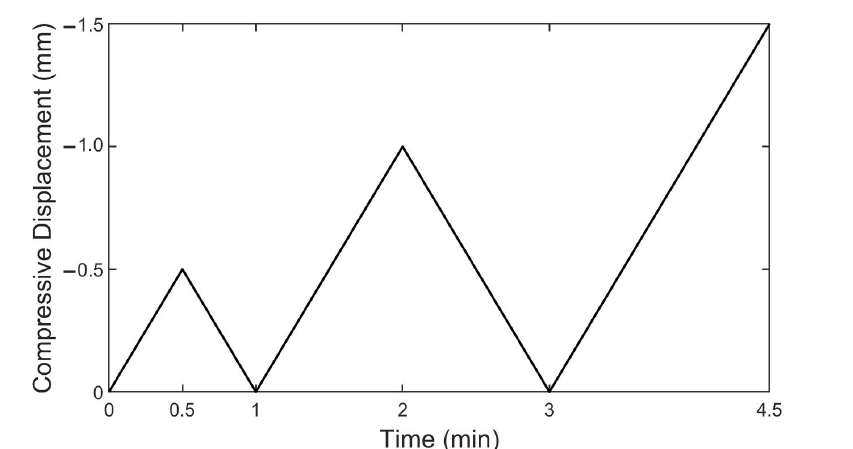
Figure 7. Compressive load profile for chiral